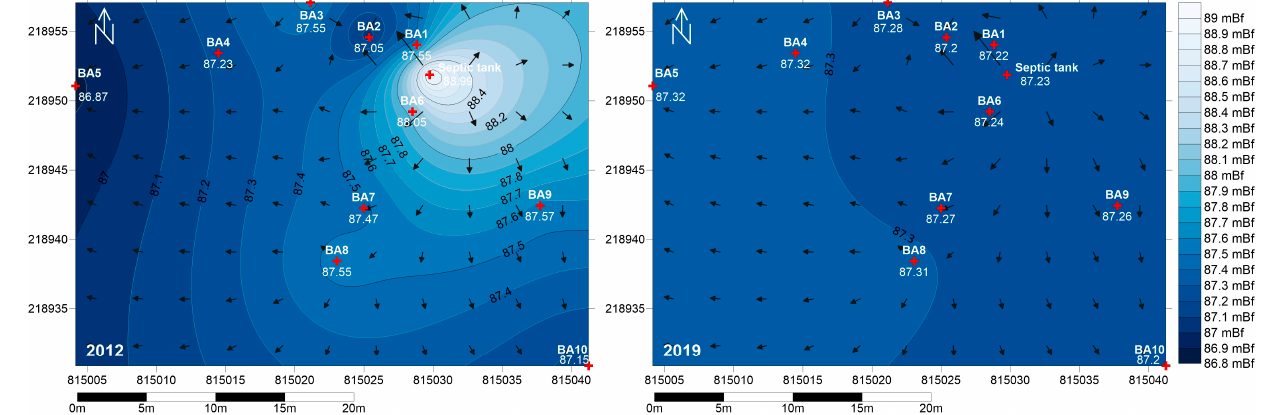
Figure 3. Interpolated maps of groundwater level in the operational phase of the septic tank in the summer of 2012 and five years after the closure in the summer of 2019.